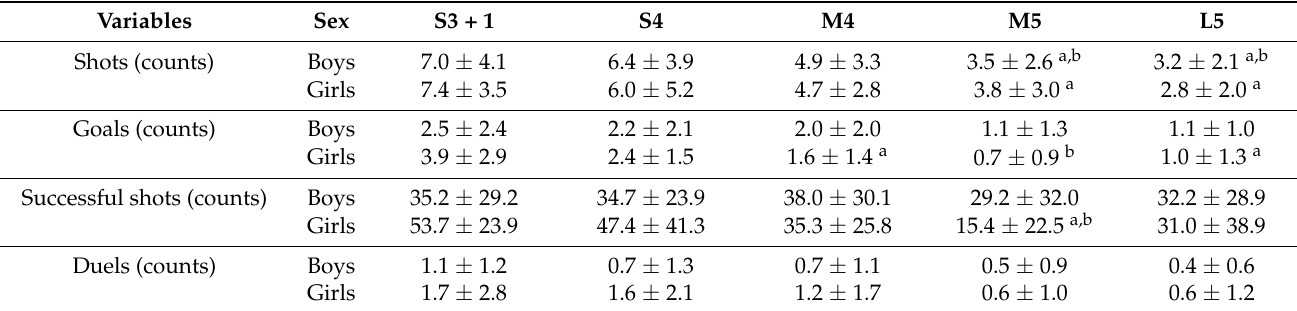
Table 2. Differences in technical demands between game formats. Data are mean ± SD .